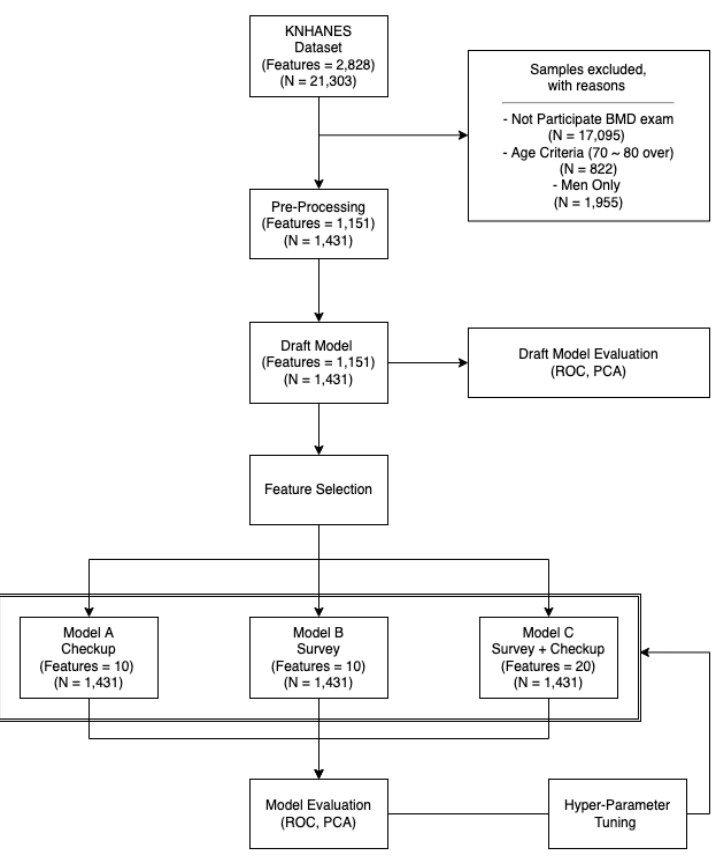
Figure 1. Study procedure. Model A—trained Model based on checkup features. Model B—trained Model based on survey features. Model C—trained Model based on total (checkup + survey)